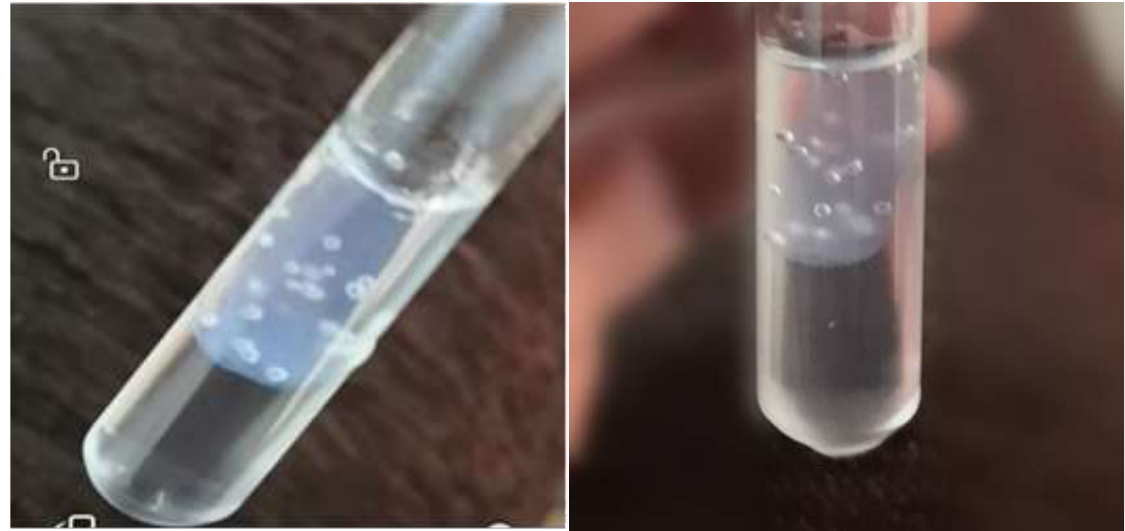
Figure 2.Phase separation of F6 when the temperature was raised to 65° C pH Measurement